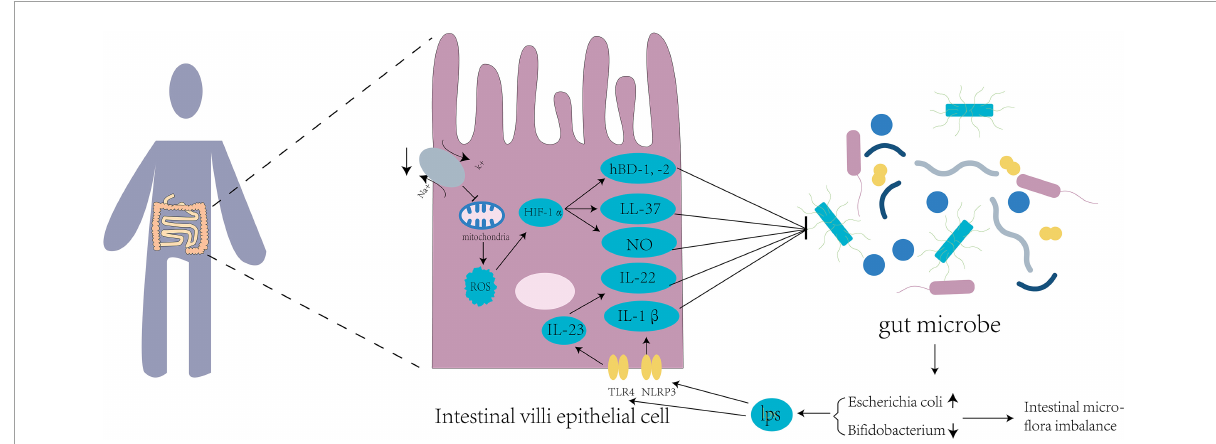
FIGURE1 Tl R4 signaling pathways and inflammatory mediators disturb the intestinal flora of the host. Mitochondrial function is inhibited by suppression of sodium and potassium pumps at high altitude, leading to excessive production of reactive oxygen species (ROS) in the mitochondria and increased expression of hypoxia-inducible factor 1 α (HIF-1 α ), thus producing nitric oxide (NO) and antibacterial peptides HBD-1, HBD-2, and LL-37. Intestines at high altitude produce excessive lipopolysaccharides (LPS) into the blood circulation, which increases the expression of TLR4 and NLRP3 in the intestinal epithelial cells. TLR4 upregulates the expression of IL-23 and downstream target IL-22, while NLRP3 upregulates the expression of IL-1 β . These factors affect the intestinal flora of populations living in Qinghai-Tibet